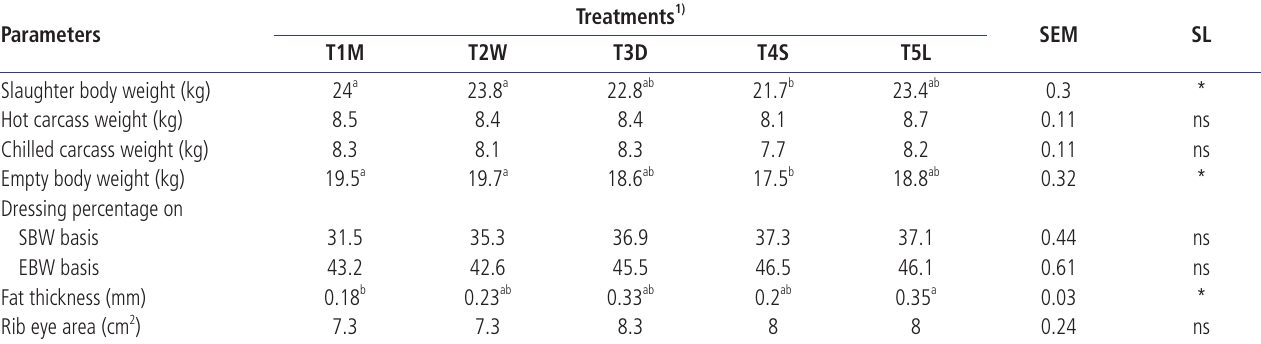
Table 5. Carcass characteristics of Arsi-Bale sheep fed diets containing different varieties of faba bean straw (70%) and concentrate (30%)